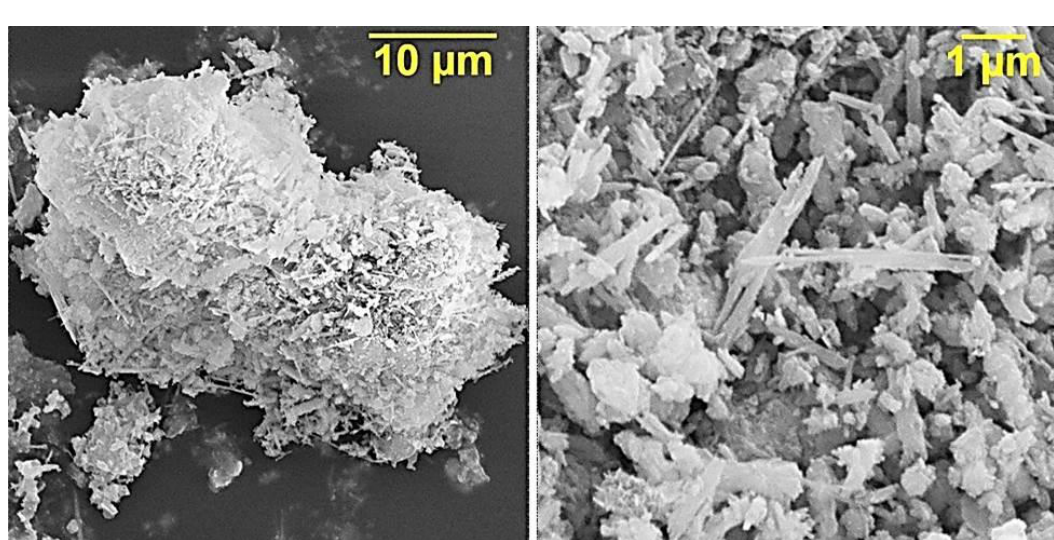
Figure 4. SEM data of ocher particles.